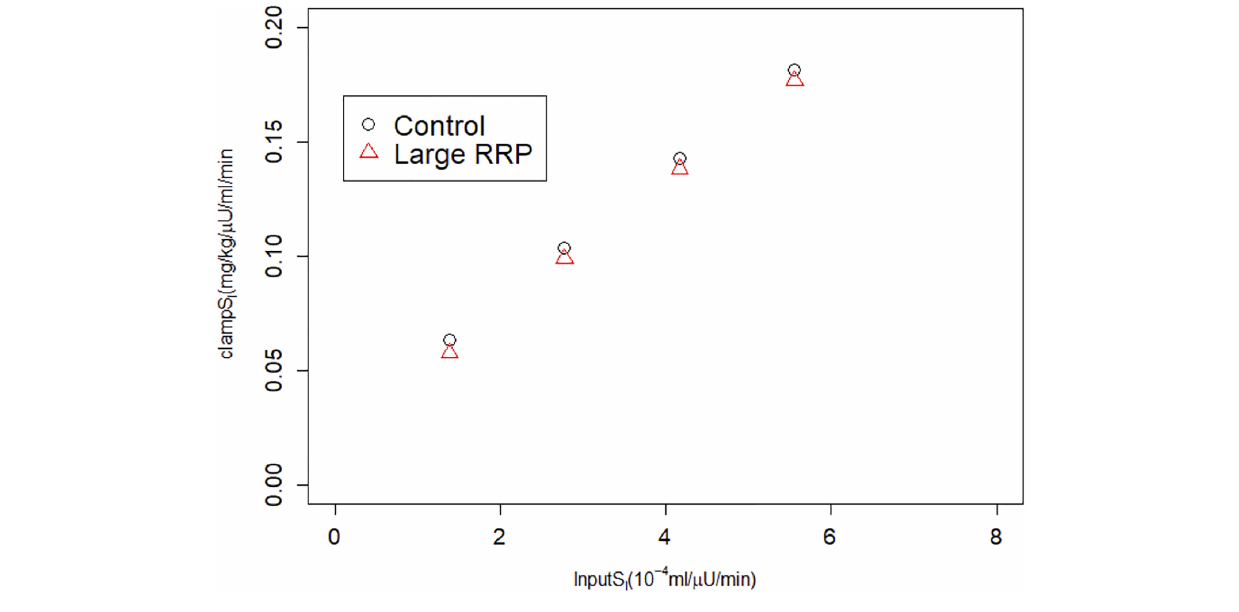
Frontiers in Physiology |